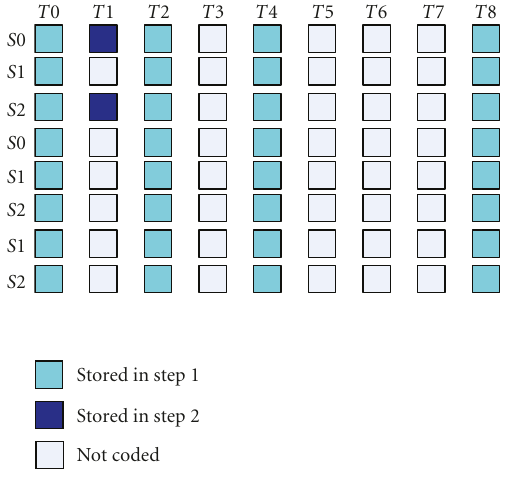
Figure 6: DPB status for time-first coding.